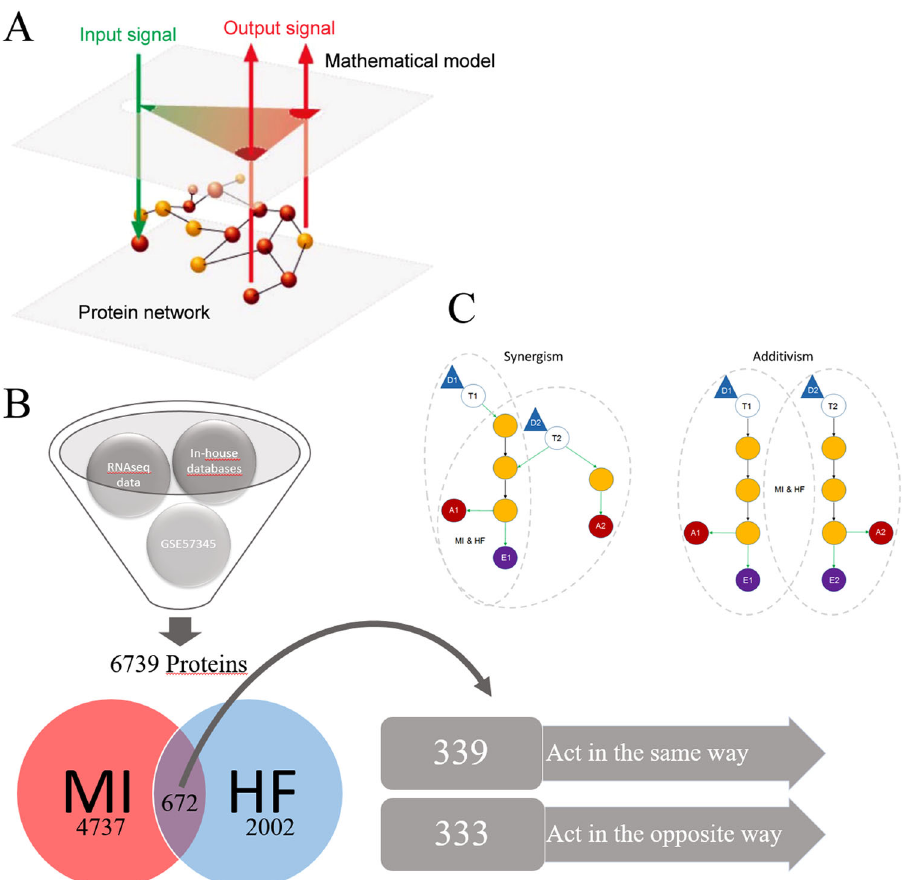
Fig. 1 Schematic representation of the mathematical model work fl ow. a Illustration of the input/output data fl ow. Once all the information is available around Sacubitril/Valsartan targets (eg. Drugbank), the pathophysiology of both conditions (MI and HF) (input signals, green arrows ) and its links to cardiac remodeling (output signals; red arrows ) have been identi fi ed and characterized at the protein level, the protein network is built. Then the models are trained with all this information and emit how the system is more likely to respond at the protein level (whether by up-regulation or down-regulation) after a certain treatment. Thus, we can elucidate one MoA that is able to explain how the system goes from the stimulus (input) to the observable clinical response (output). b Depiction of data processing using TPMS technology. c Synergism/ additivism schemes. Triangular shapes represent drug administration. Void circles act as the drug targets. Yellow circles represent downstream proteins participating on the cascade. Red and purple circles refer to different types of effects. Gray dotted-line patterns show the pathways of each condition, marking if there is a common share. MI myocardial infarction, HF Heart